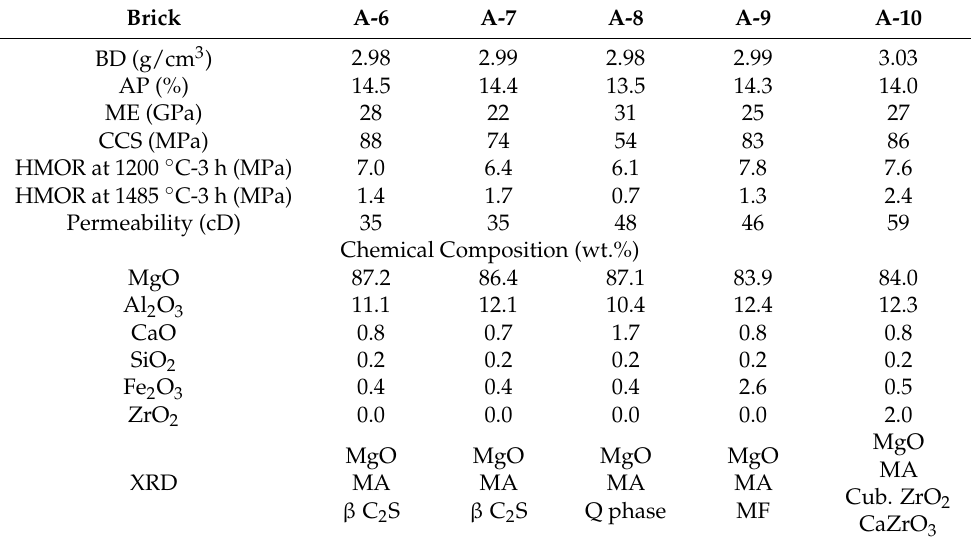
Table 4. Properties of magnesia–spinel brick compositions fired at 1700 ◦